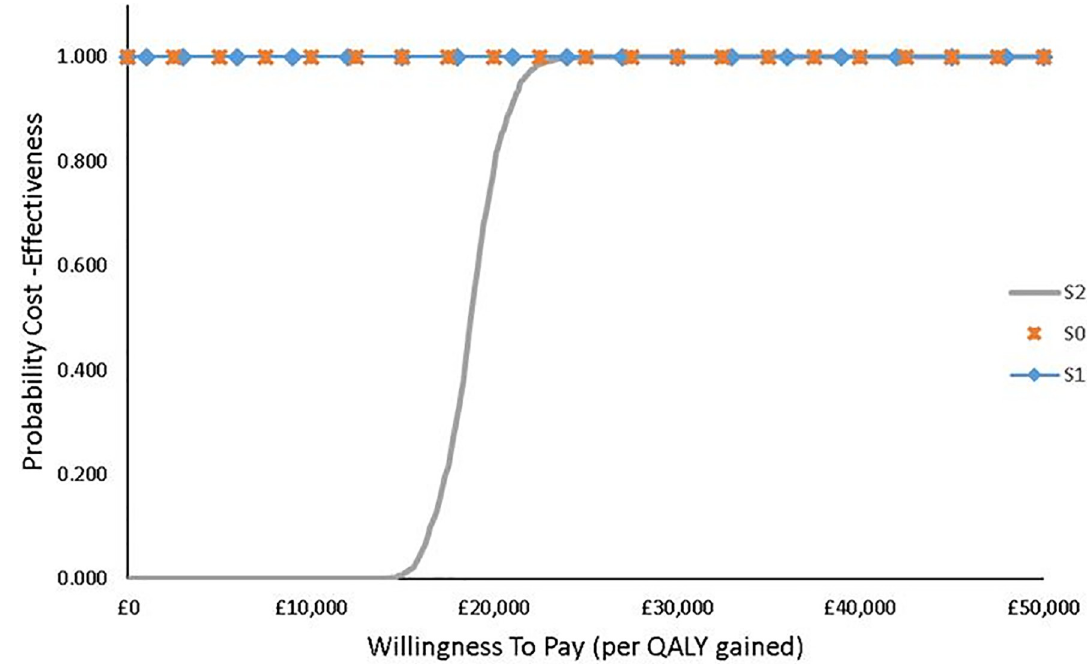
Fig 4. CEAC showing the probability of cost-effectiveness of FlowOx ™ therapy plus standard care at different WTP threshold levels (all